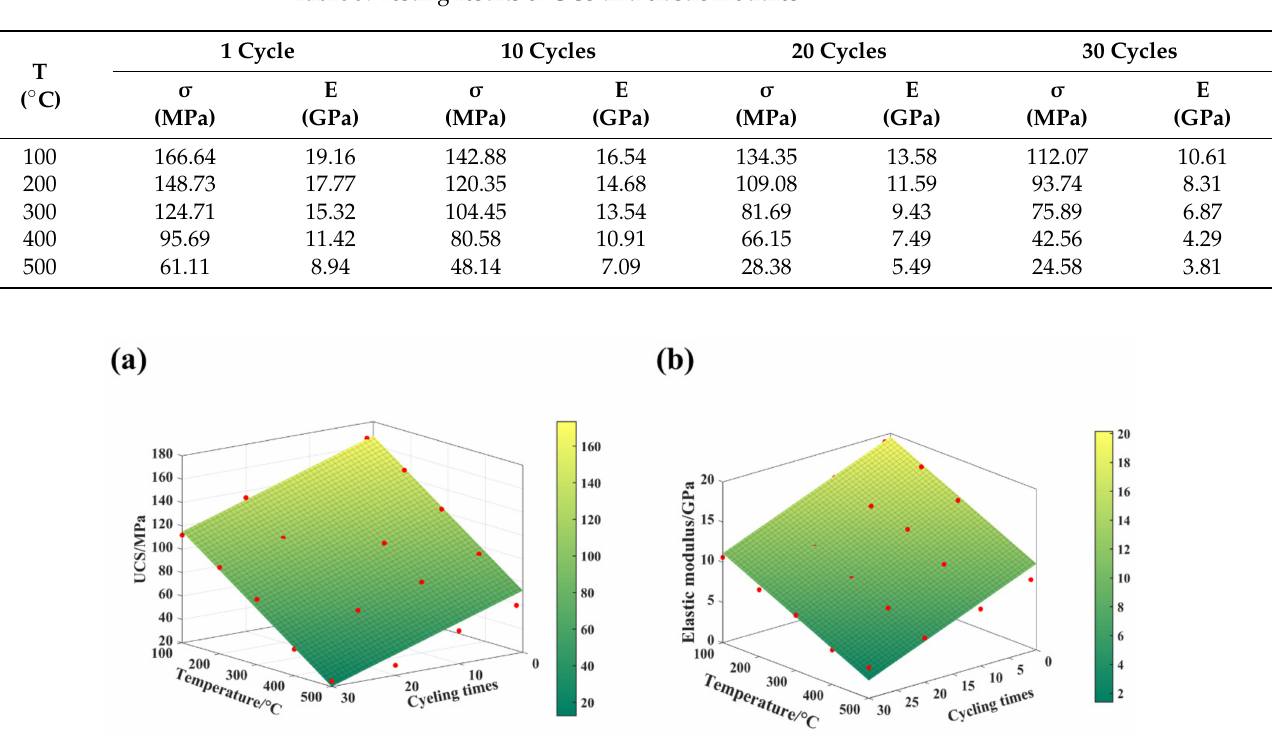
Table 3. Testing results of UCS and elastic modules.